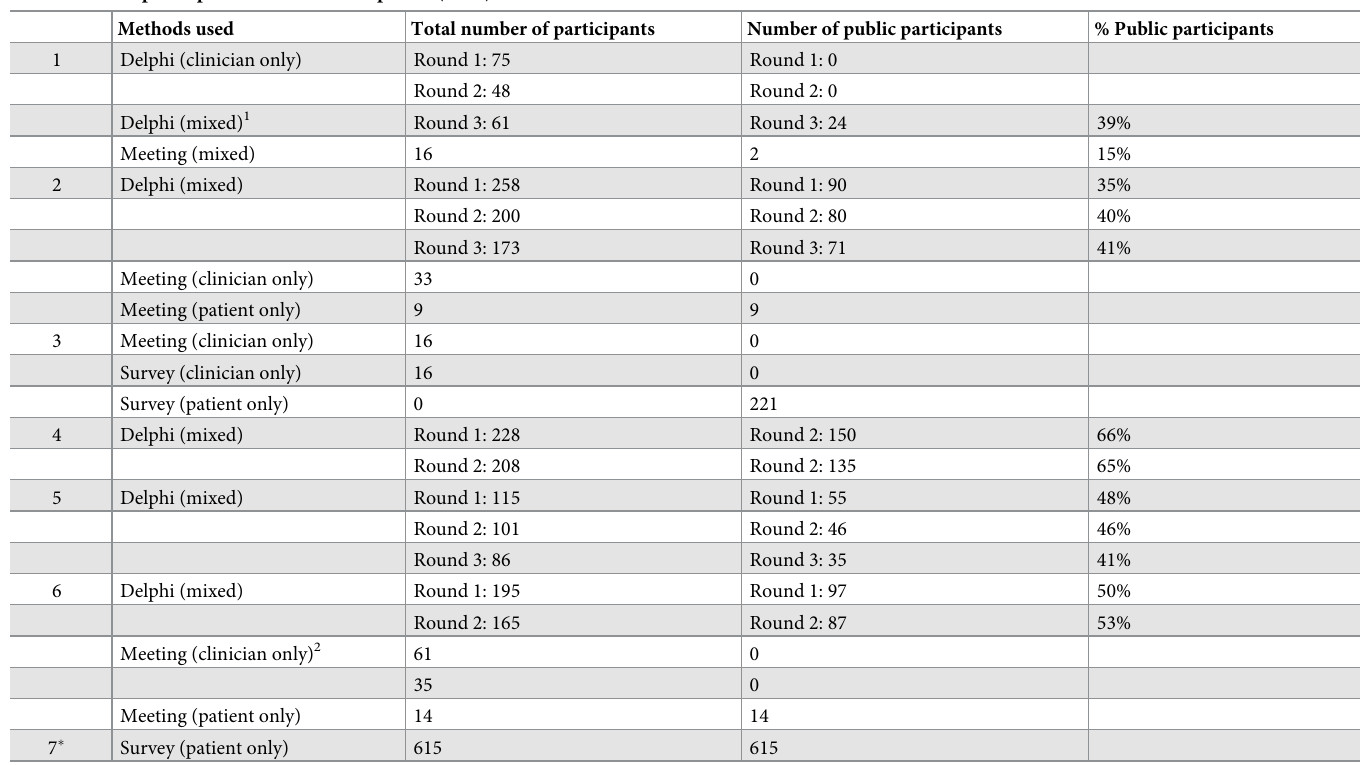
Table 5. Public participation detail where reported (n = 7).